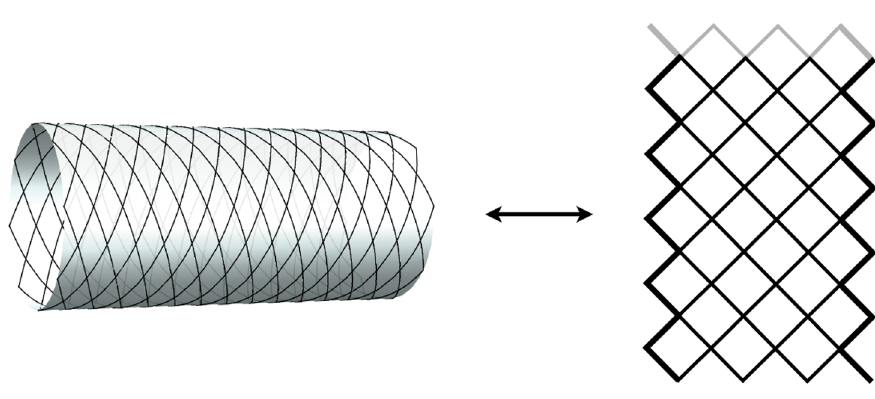
Figure 1 . The 6-vertex model on a cylinder. In the open channel, there are 2 M + 1 sites in the horizontal direction with free boundary conditions, and 2 N sites in the vertical direction with periodic boundary conditions.